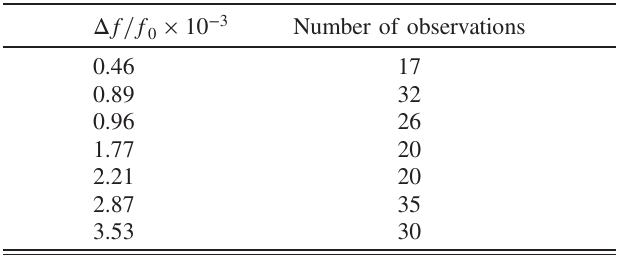
TABLE I. NumberofdimerpairsobservedforFigs.2(d)and2(e). Each dimer was observed for 23 seconds.